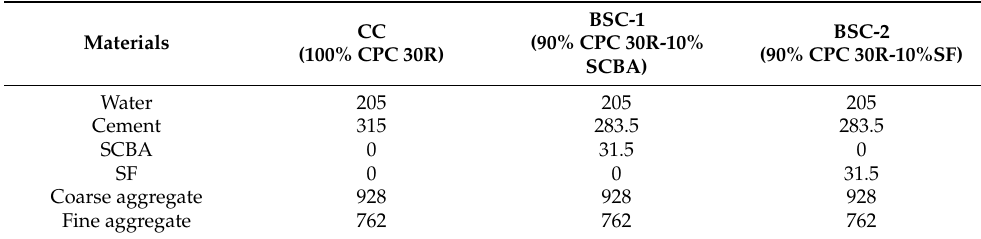
Table 2. Dosage of conventional concrete and binary sustainable concrete, (kg/m 3 of concrete, ratio w/c = 0.65).